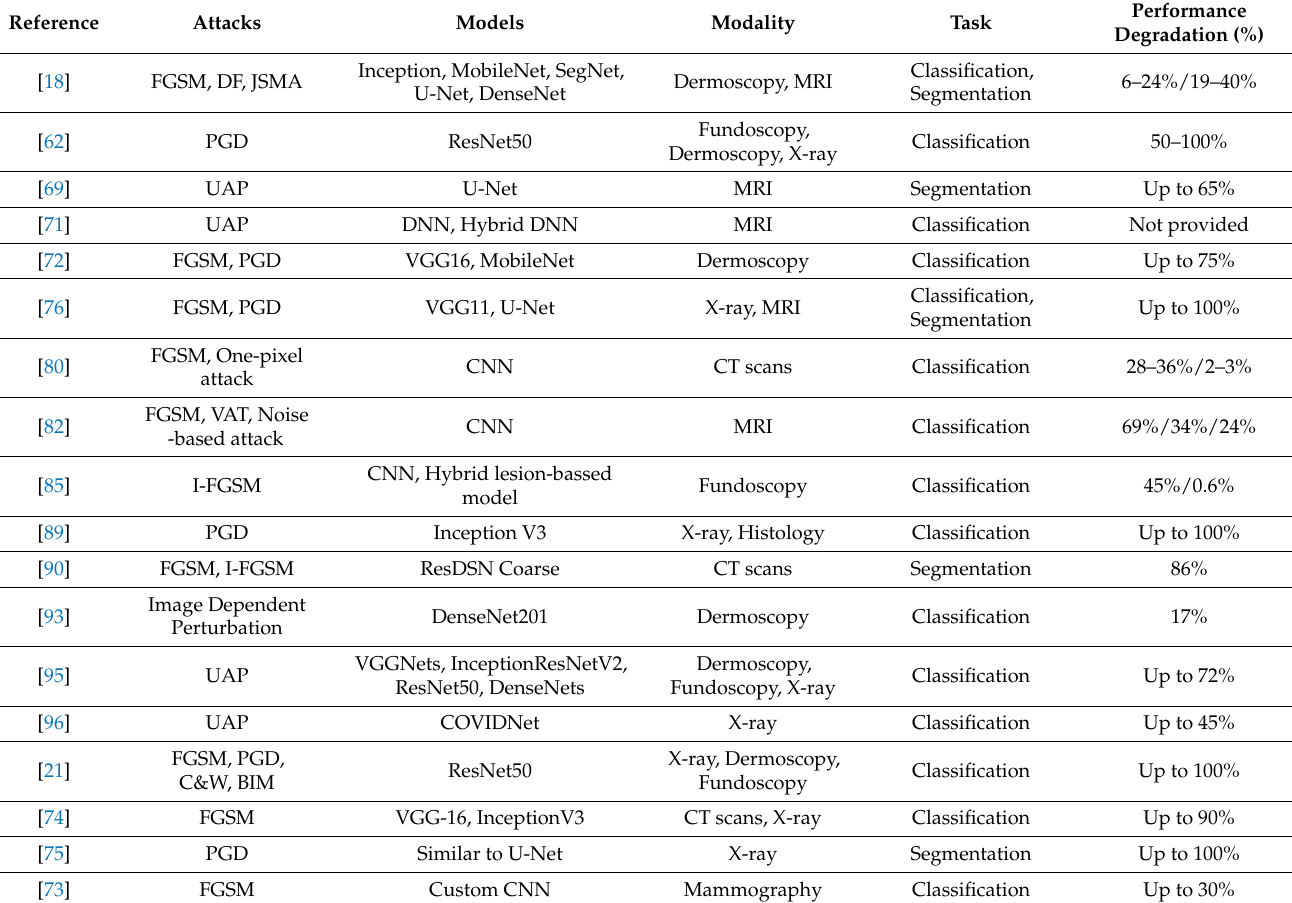
Table 1. Overview of existing adversarial attacks on medical